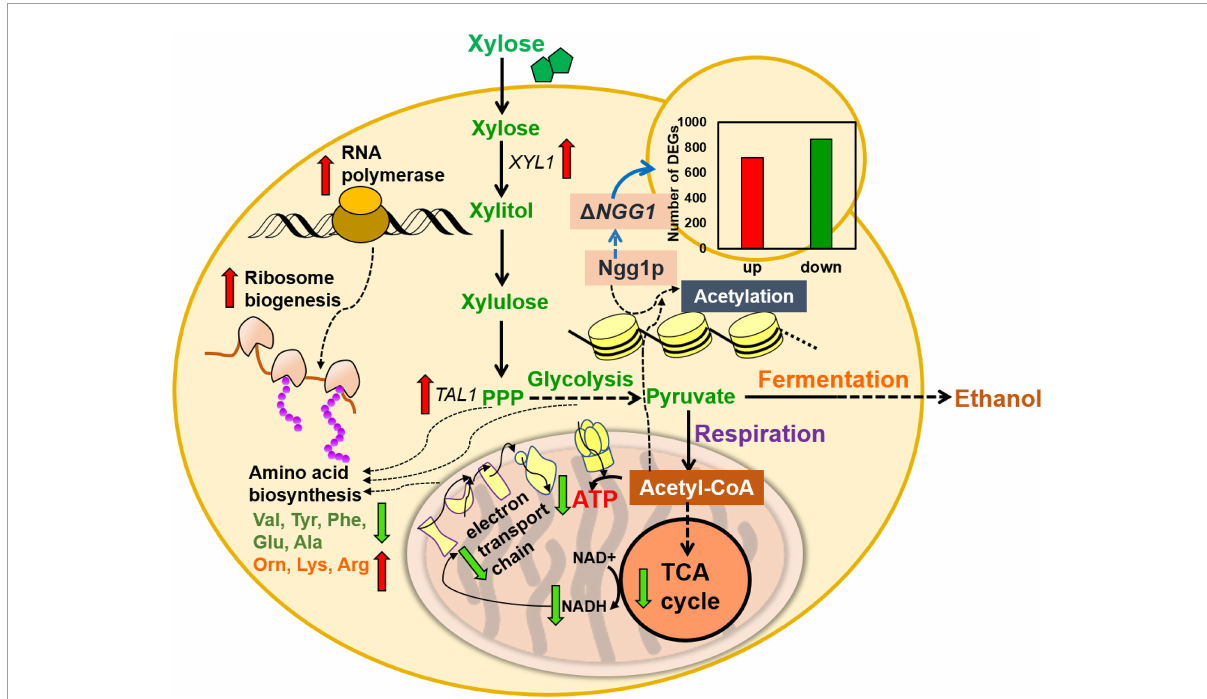
FIGURE6 Proposed model for improved xylose metabolism by NGG1 deletion in S. cerevisiae YRH396h. The down-regulated genes primarily participated in mitochondrial function, TCA cycle, ATP biosynthesis, respiration, as well as NADH generation. The NGG1 deletion mutant also showed different content of intracellular amino acids compared to the control